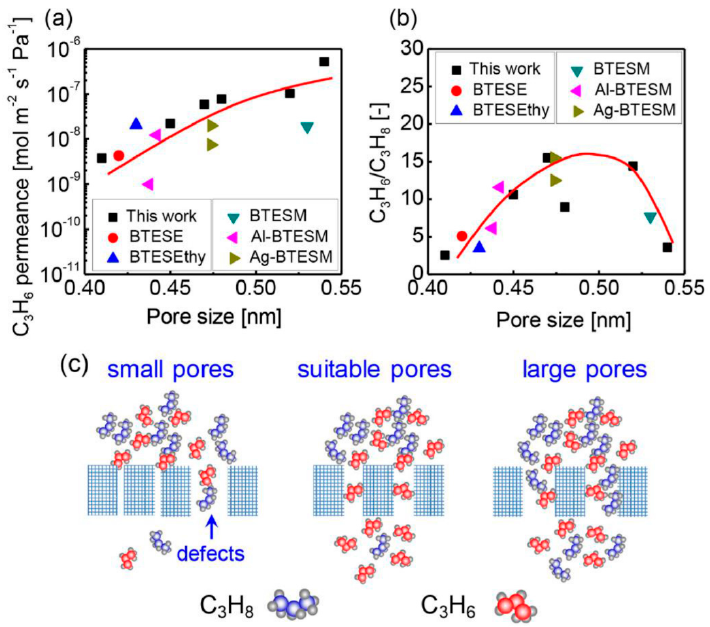
Figure 14. Relationships between pore size and single gas permeation properties: ( a ) C 3 H 6 perme- ance and ( b ) C 3 H 6 /C 3 H 8 permeance ratio at 200 °C for a variety of (composite) organosilica membranes. ( c ) Possible schematic image for C 3 H 6 /C 3 H 8 separation utilizing organosilica membranes with different pore sizes [101].